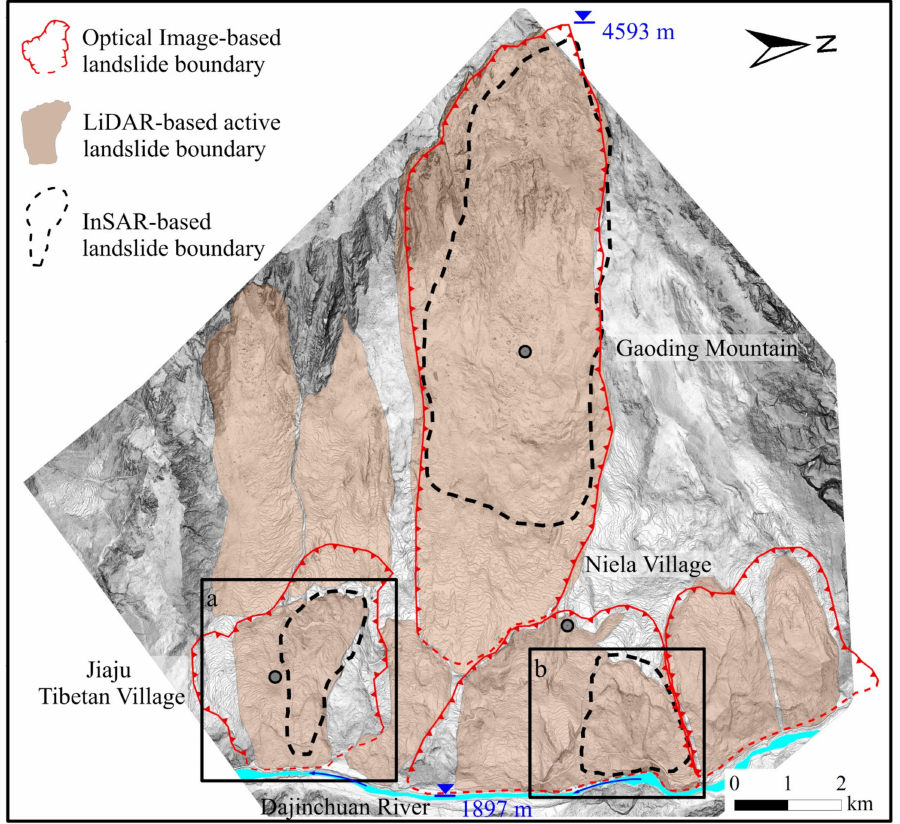
Figure 6. Comparison of identification boundaries from three technologies: ( a , b ) were selected for detailed